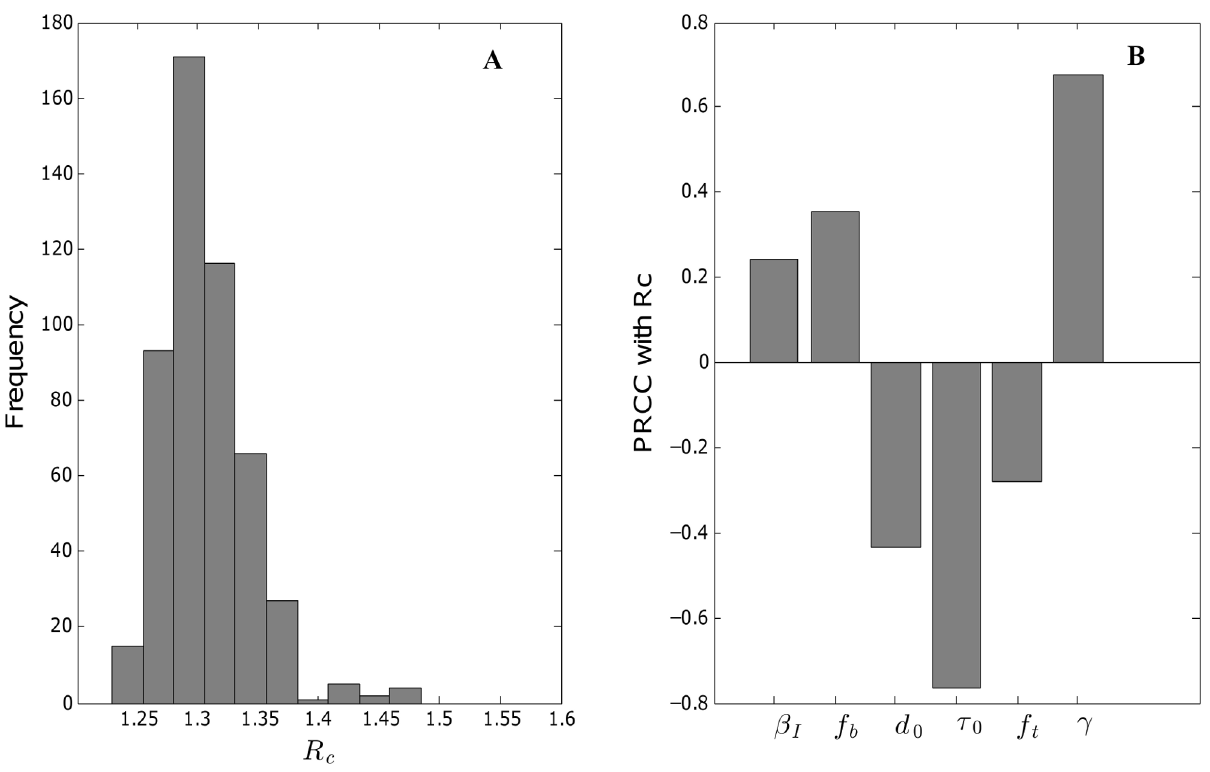
Figure 4. Uncertainty and sensitivity analyses on the control reproduction number R c . Histogram of R c (A) and PRCC of parameters with R c (B) with parameter uncertainty (based on a random sample of size 500 of Markov chain for parameters).